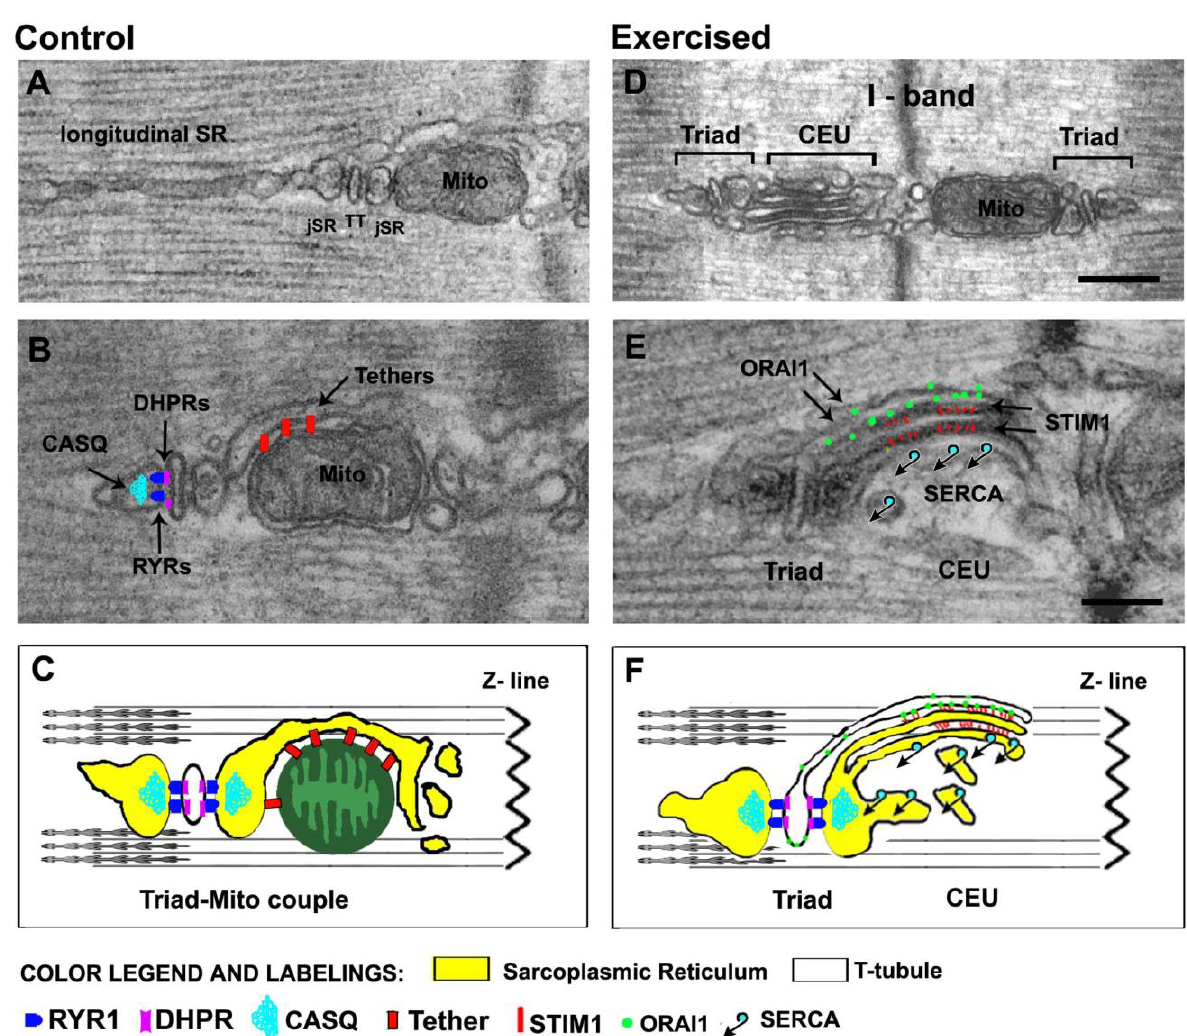
Figure 2. Architecture of the membrane systems and organelles involved in Ca 2+ handling and aerobic ATP production. ( A – C ) In adult mammalian fibers, triads (or CRUs) are placed approximately at the A–I band transition when sarcomeres are relaxed. The SR that does not participate in the formation of junctions with TT constitutes the longitudinal SR, placed either at the A or I band. Triads contain the molecular players of EC coupling (RYRs, DHPRs, and CASQ) shown in panel ( B ) and are tethered to mitochondria, which are preferentially placed at the I band. In panel C, the cartoon shows a mitochondrion-triad couple. ( D – F ) Following acute exercise, sarcotubular membranes at the I band (both SR and TTs), are capable of significant remodeling, which eventually leads to the assembly of CEUs. CEUs are formed by SR-stacks, coupled with a TT and contain the molecular players of SOCE (STIM1 and ORAI1) shown in panel ( E ). In panel ( F ), the cartoon shows a triad and a CEU, two intracellular junctions which are structurally and molecularly different. Scale bars: ( D ) 0.2 µ m; ( E ) 0.1 µ